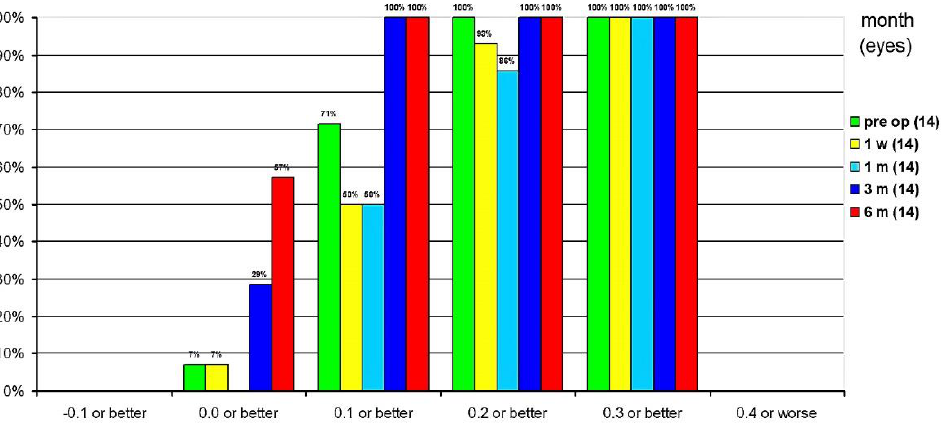
Figure 6. Cumulative corrected distance visual